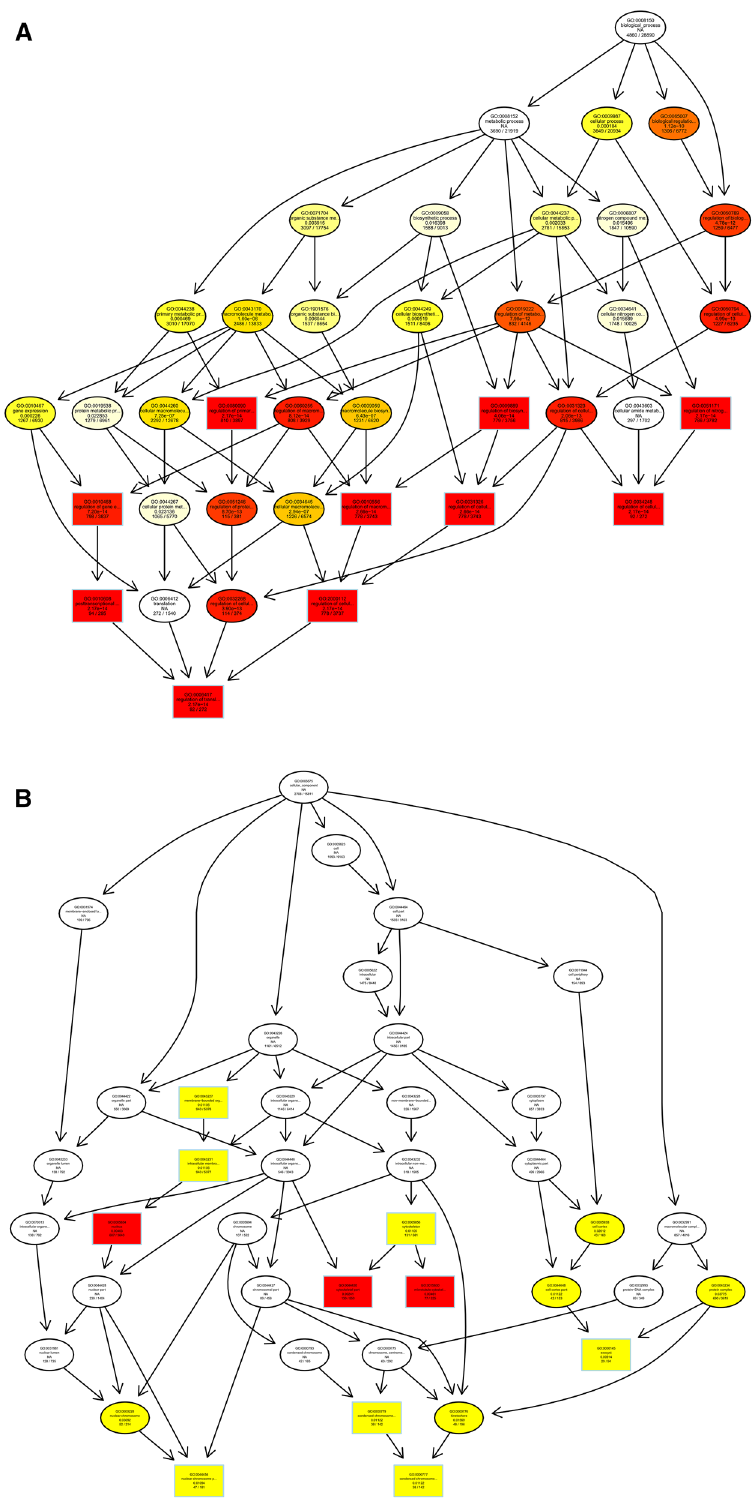
Figure 8. Differentially expressed miRNAs in ginseng tissues predicted the GO enrichment analysis of target genes. Image generated with R 3.6.3 (https:// www.R- proje ct. org) 51 ggplot2 package (https:// ggplo t2. tidyv erse.